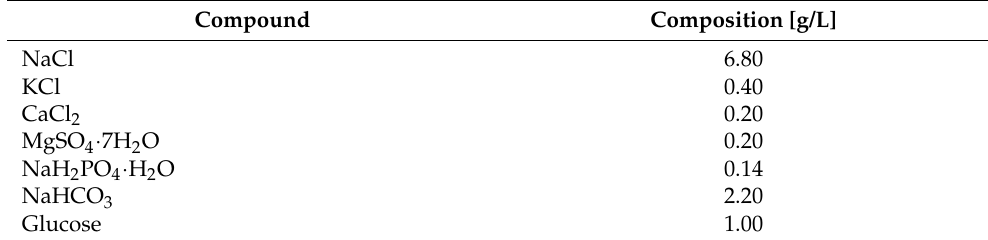
Table 2. Composition of simulated body fluid (SBF).